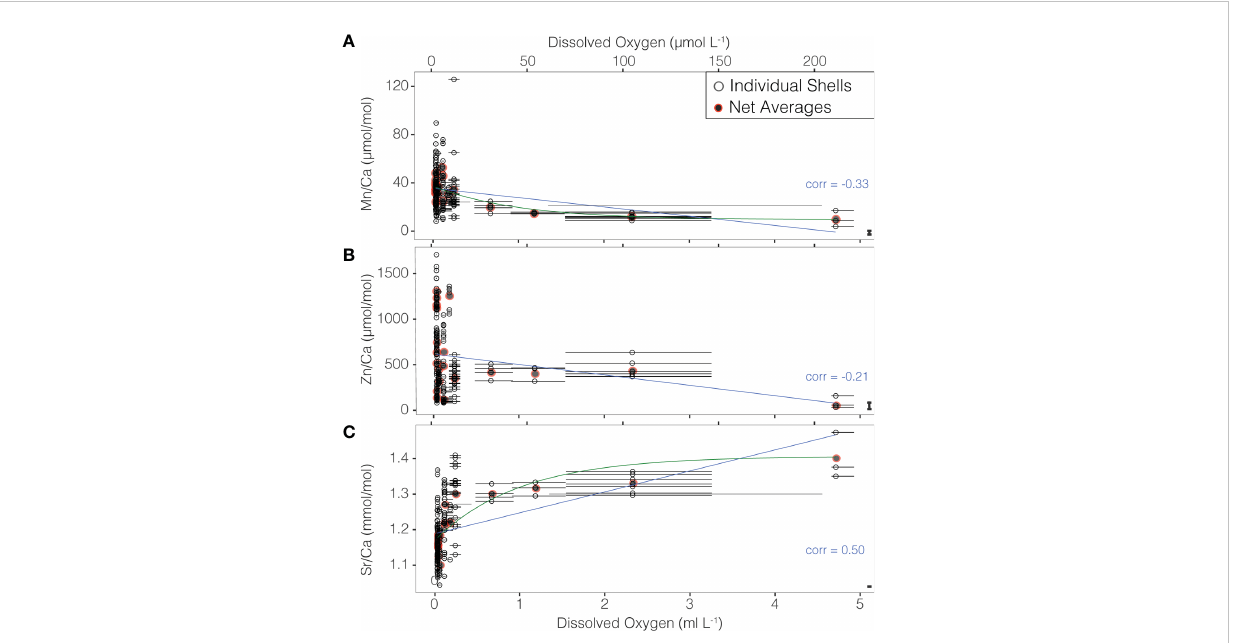
FIGURE 3 (A) Mn/Ca, (B) Zn/Ca, and (C) Sr/Ca values of individual shells (open black points), and net means (closed gray/red points) relative to in situ oxygen at collection. Points are plotted against the mean oxygen within the net from which the foraminifers were collected, and horizontal bars show the minimum to maximum values of oxygen measured within each net. Signi fi cant linear correlations are shown as blue lines. Exponential fi ts are shown in green in panels (A, C) . The mean difference between duplicate ablations of the same chamber is show as a bar in the bottom right of each